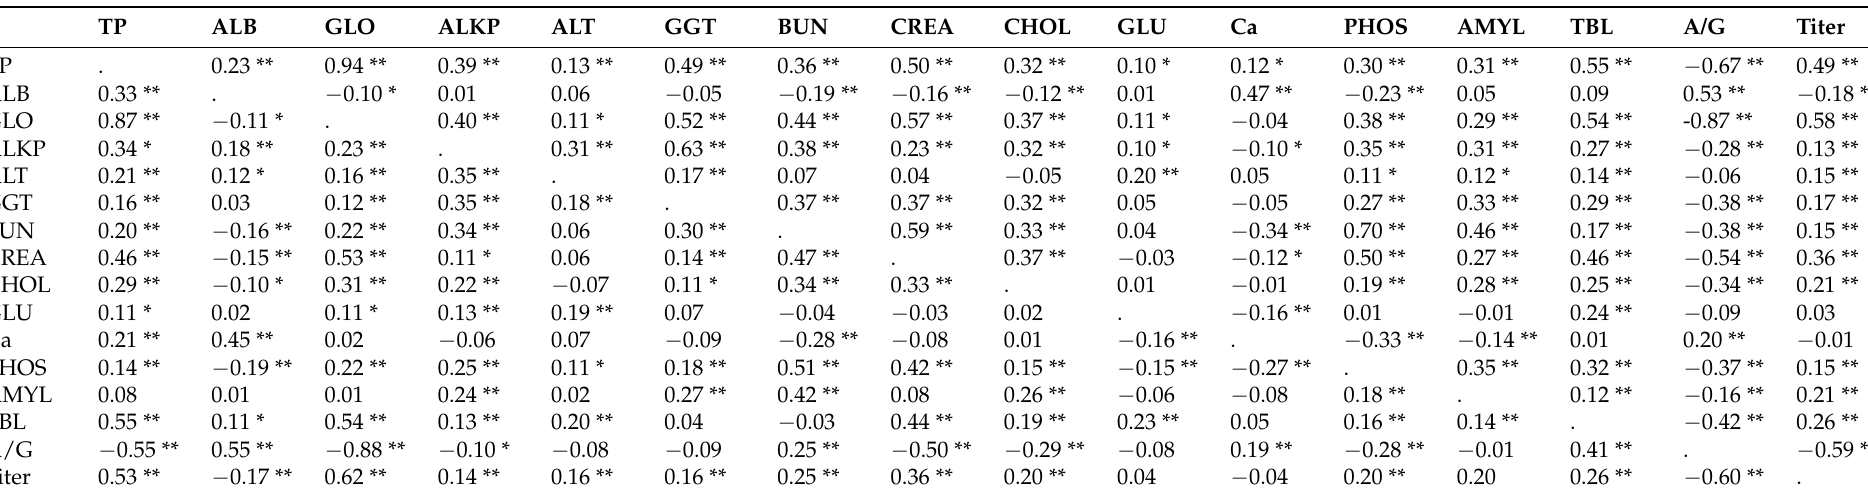
Table 9. Pearson correlation coefficients of original (above diagonal) and Box–Cox transformed data (below diagonal) among serum analytes and with log2 antibody titer at